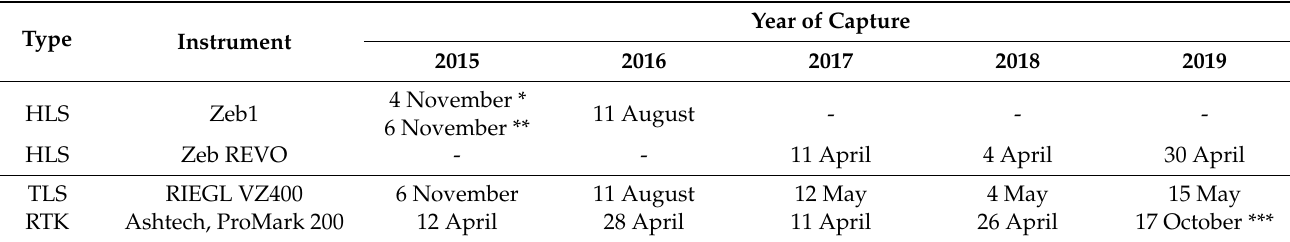
Figure 1. Oblique view of gully in this study. Uphill is to top left, downstream is to bottom right. Location of survey markers shown in yellow (TLS bases), green (RTK bases) and black (steel posts). A typical headcut RTK survey is shown in red with the inset illustrating the typical vertical headcut morphology near the headcut survey. Downstream of the headcut, the gully walls are generally steep (contours), but not undercut. Locations of RTK cross sections are shown in brown and represent profiles immediately upstream of check dams. Along with HLS surveys, RTK and TLS field data were collected annually post wet season and are used as validation datasets for this study. Erosion pins were also used to monitor sidewall erosion, but the changes observed [13] were below the threshold of detection of the HLS and are not included in this study. Five permanent ground-level TLS bases and 14 concrete RTK bases are located around the gully. Steel posts are located adjacent to these bases as well as the ends of repeat RTK cross section profiles at check dams and other key monitoring sites (Figure 1). Table 1. Dates of capture and instrument specifications for all HLS, RTK and TLS captured at the gully for the period of this